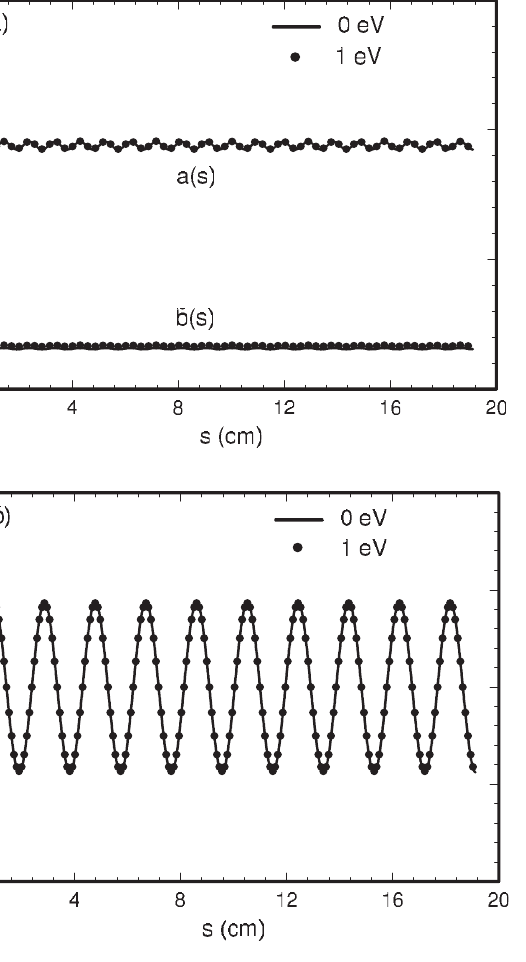
FIG. 3. Plots of (a) envelopes a (cid:3) s (cid:4) and b (cid:3) s (cid:4) and (b) twist angle (cid:3) (cid:3) s (cid:4) versus the axial distance s for the nonrelativistic twisted elliptic beam. The solid curves are the generalized envelope solution for a zero-temperature beam, whereas the dotted curves are for a 10 eV on-axis temperature